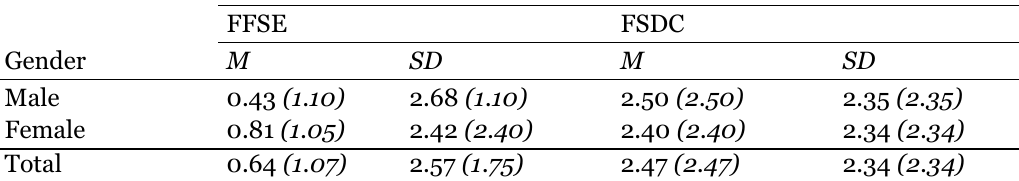
Dropout Score by Gender and Region (Without